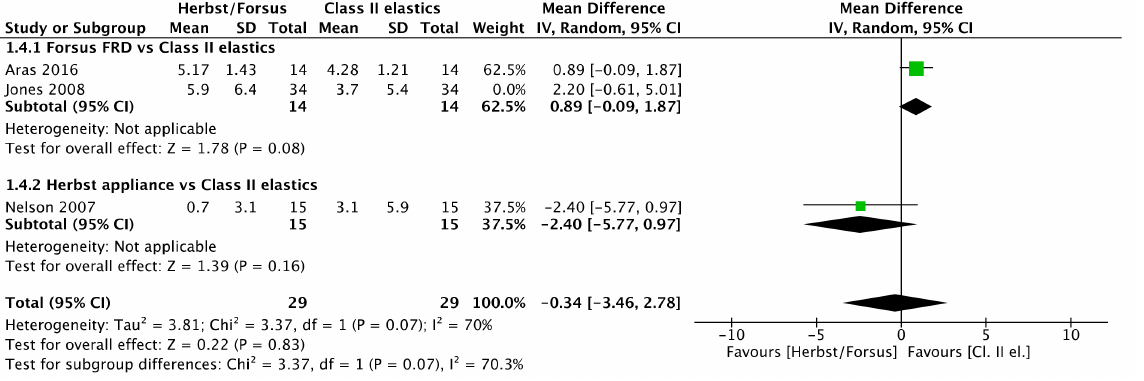
Figure 27. Forest plot of the sensitivity analysis on lower incisor inclination changes using the random effects model [39,46].